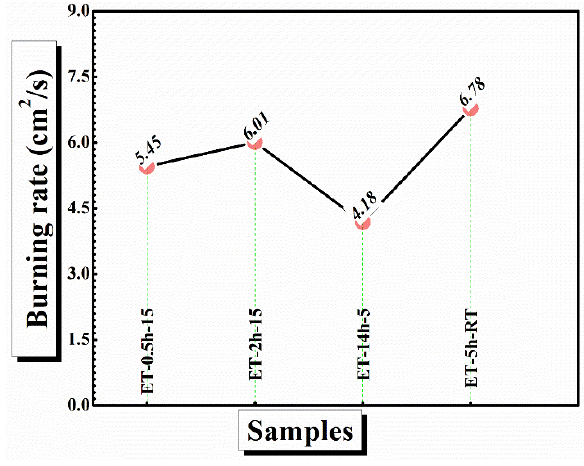
Figure 10. Burning rate of the coated cotton obtained from VFT analysis.